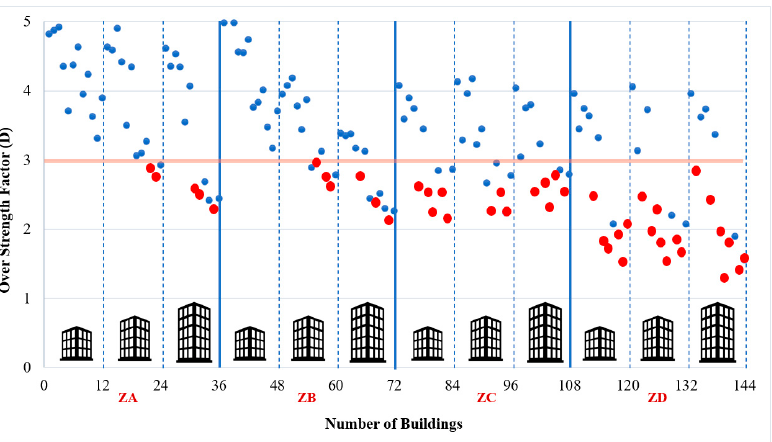
Figure 19. Distribution of the over-strength factor for all models according to the number of buildings and soil types (for linear analysis).